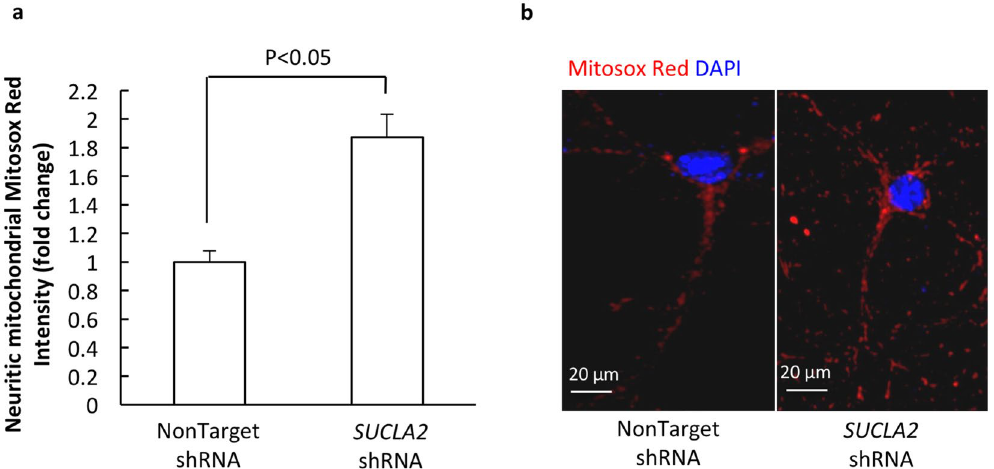
Figure 3. Loss of SCS A- β enhances neuronal mitochondrial superoxide production. SUCLA2 shRNA- challenged neurons had significantly increased levels of Mitosox Red intensity ( a ). ( b ) are the representative images of Mitosox Red (red) staining. The nuclear was visualized by the staining of DAPI (blue). The data were collected from 3 independent experiments. Scale bar = 20 µ